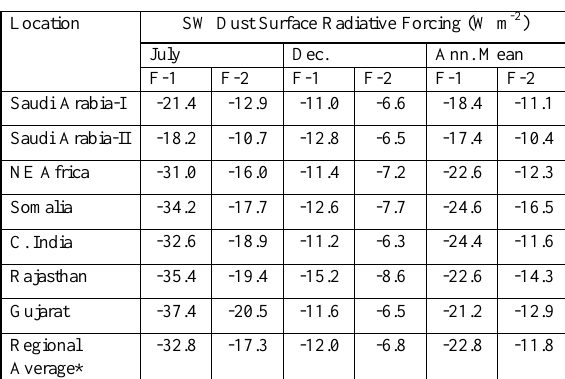
Fig. 14. A typical set of three-hourly reference images (in K). The time marked in figure is Indian Standard Time (IST). Table 6. SW dust radiative forcing at the surface for 1999. SW Dust Surface Radiative Forcing (W m -2 ) July Dec. Ann.